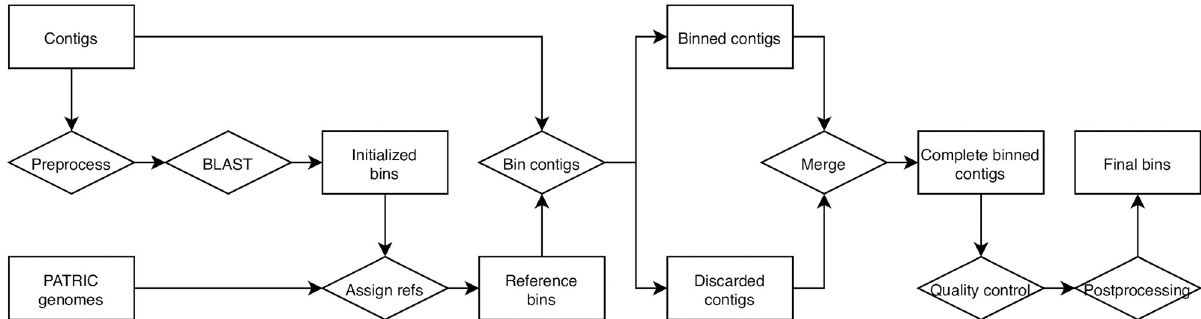
Fig 1. Flowchart of binning pipeline. This flowchart represents the process for creating bins from metagenomically-derived contigs. Bins are initialized on the basis of BLAST hits for a seed protein, then assigned references from PATRIC genomes. The remaining contigs are assigned to initialized bins on the basis of similarity to reference genomes, and then postprocessed in order to (1) relax stringent binning rules on the basis of similarity between an unallocated contig and a bin, and (2) to clean up bins with excess